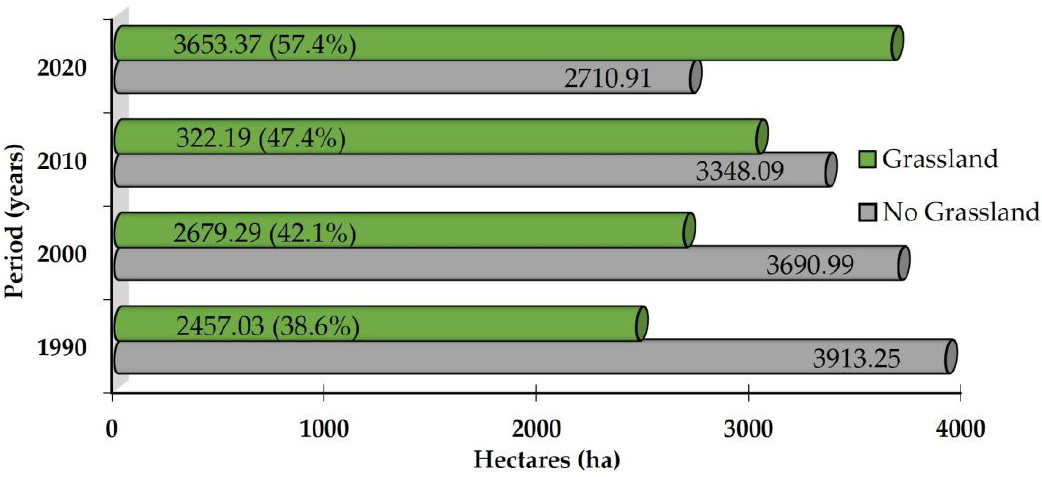
Figure 6. Area of grassland and non-grassland in 1990, 2000, 2010 and 2020 in the Pomacochas micro-watershed.